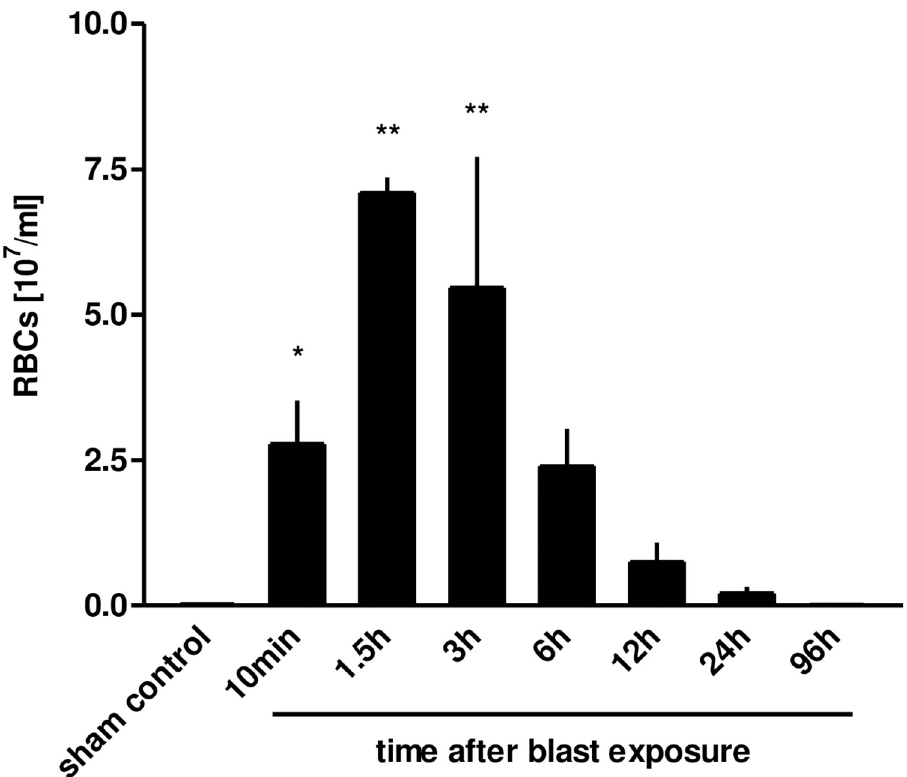
Fig 3. Blast injury-related protein accumulation in BALFs. Animals were sacrificed 10 min (n = 5), 1.5 h (n = 3), 3 h (n = 3), 6 h (n = 3), 12 h (n = 4), 24 h (n = 3) or 96 hours (n = 3) after blast exposure, non-traumatized animals served as sham controls (n = 9). Protein concentration was determined in the BALF. Data were analysed by one-way ANOVA and Dunnett’s multiple comparison test: �� p < 0.01 vs. control. Data represent means ± SEM, number of individual experiments (n) in